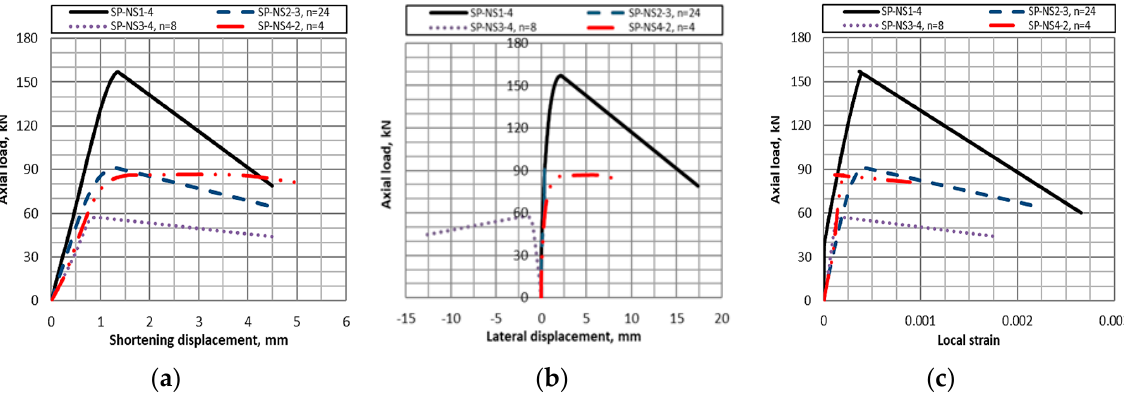
Figure 5. Axial force versus shortening ( a ), lateral displacement ( b ) and local strain ( c ), DoO = 16.80%.